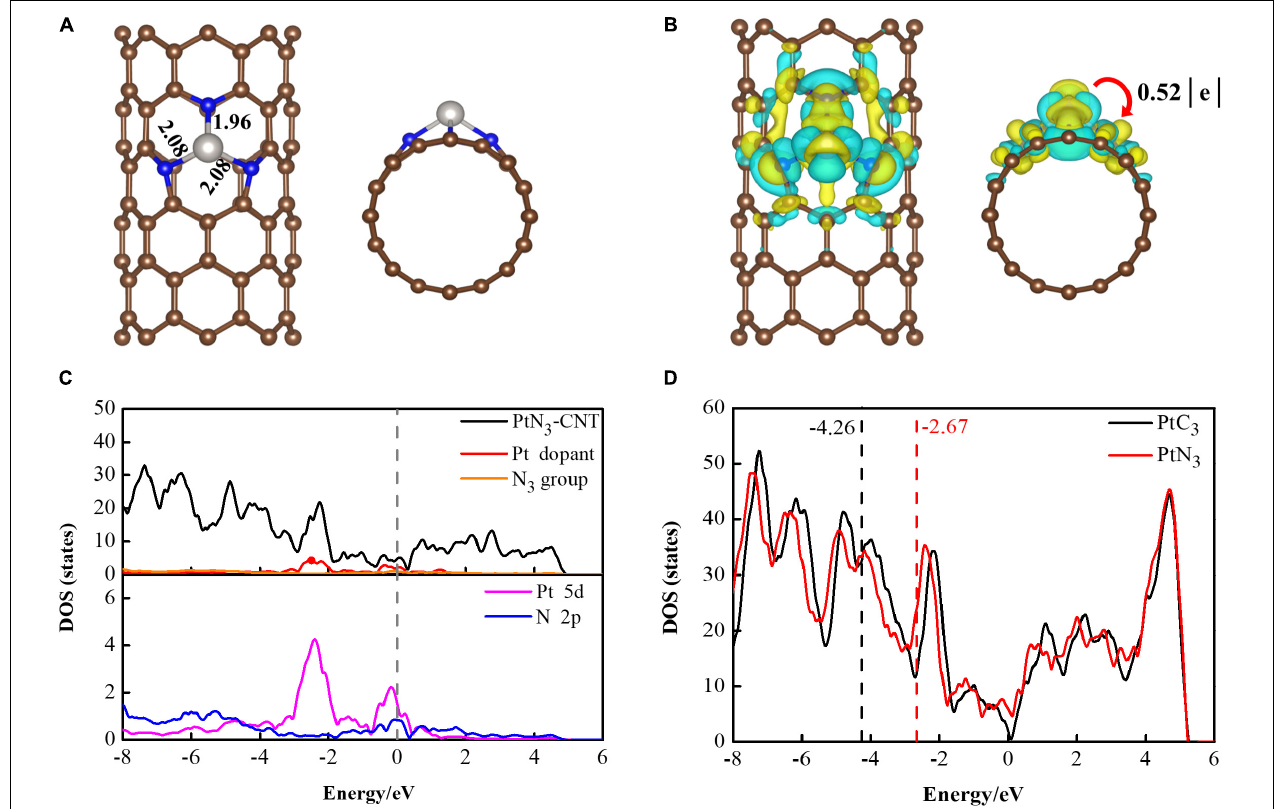
FIGURE 1 | (A) The top and side views of the optimized geometries of PtN 3 -CNT; (B) Deformation charge distribution of PtN 3 -CNT. The yellow area and cyan area represent the accumulation and consumption of electrons, respectively. The value of the isosurface level is 0.0011 e/Å 3 . (C) DOS and PDOS of PtN 3 -CNT; (D) d -band centers of PtN 3 -CNT and PtC 3 -CNT. Brown, blue, gray balls represent C, N, and Pt atoms, respectively.